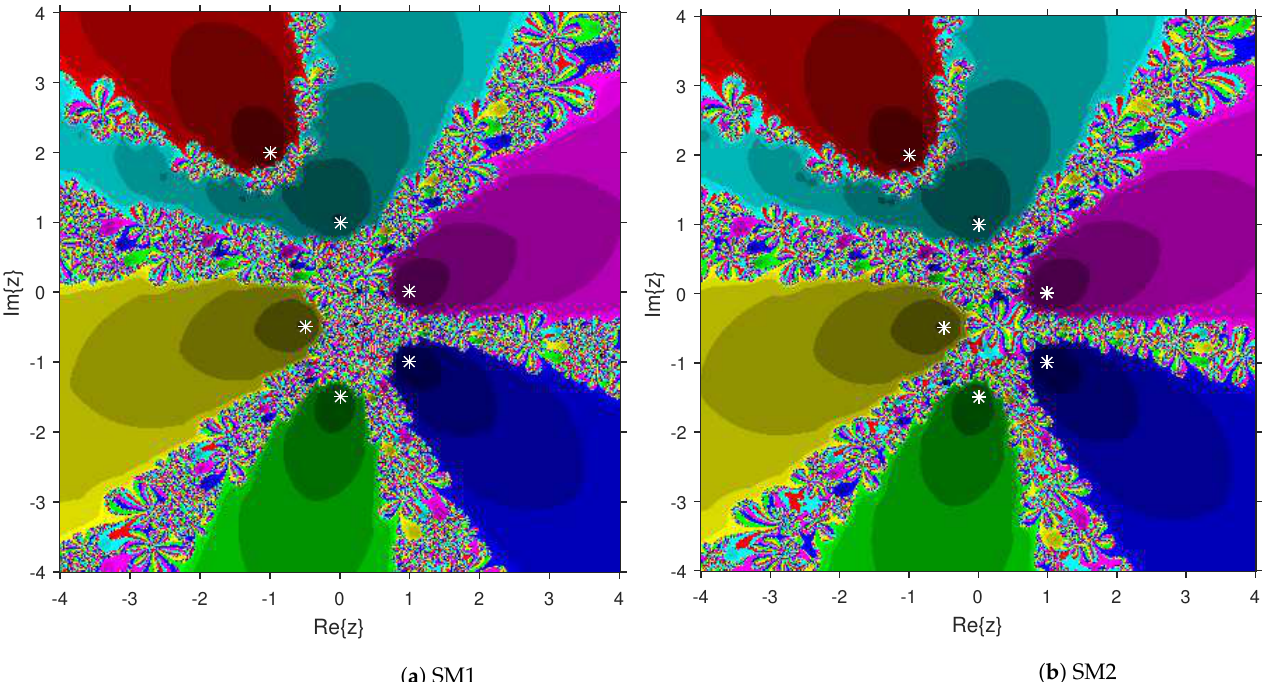
Figure 9. Attraction basins comparison between SM1 and SM2 related to M 9 ( z ) .